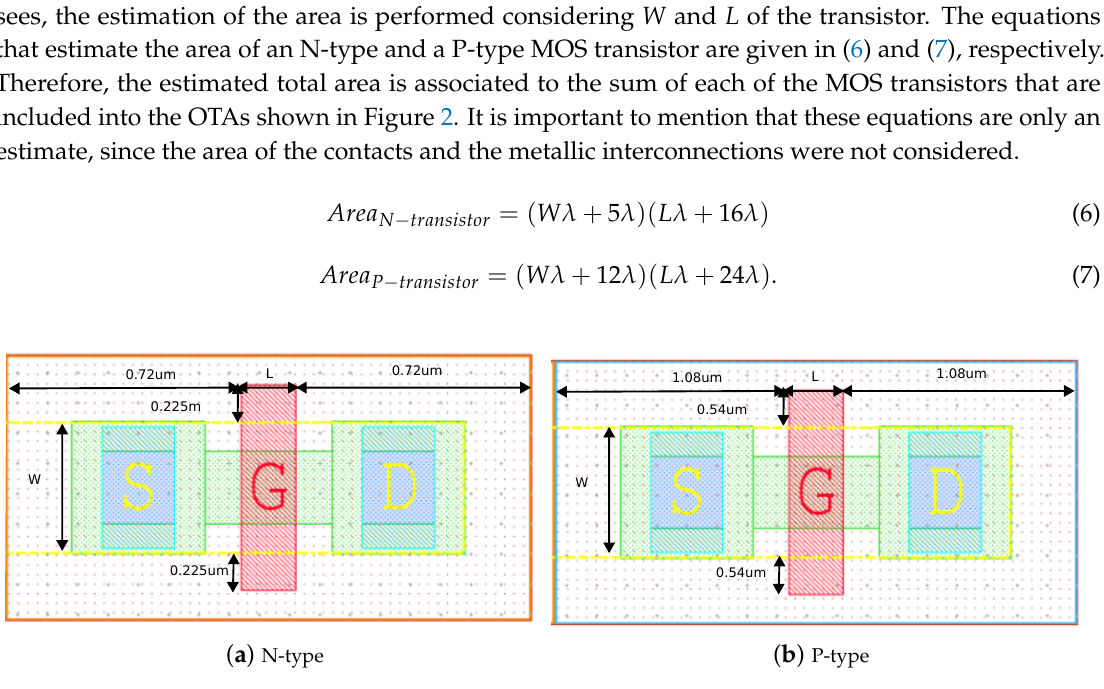
Figure 3. Layout of the N-type and P-type MOS